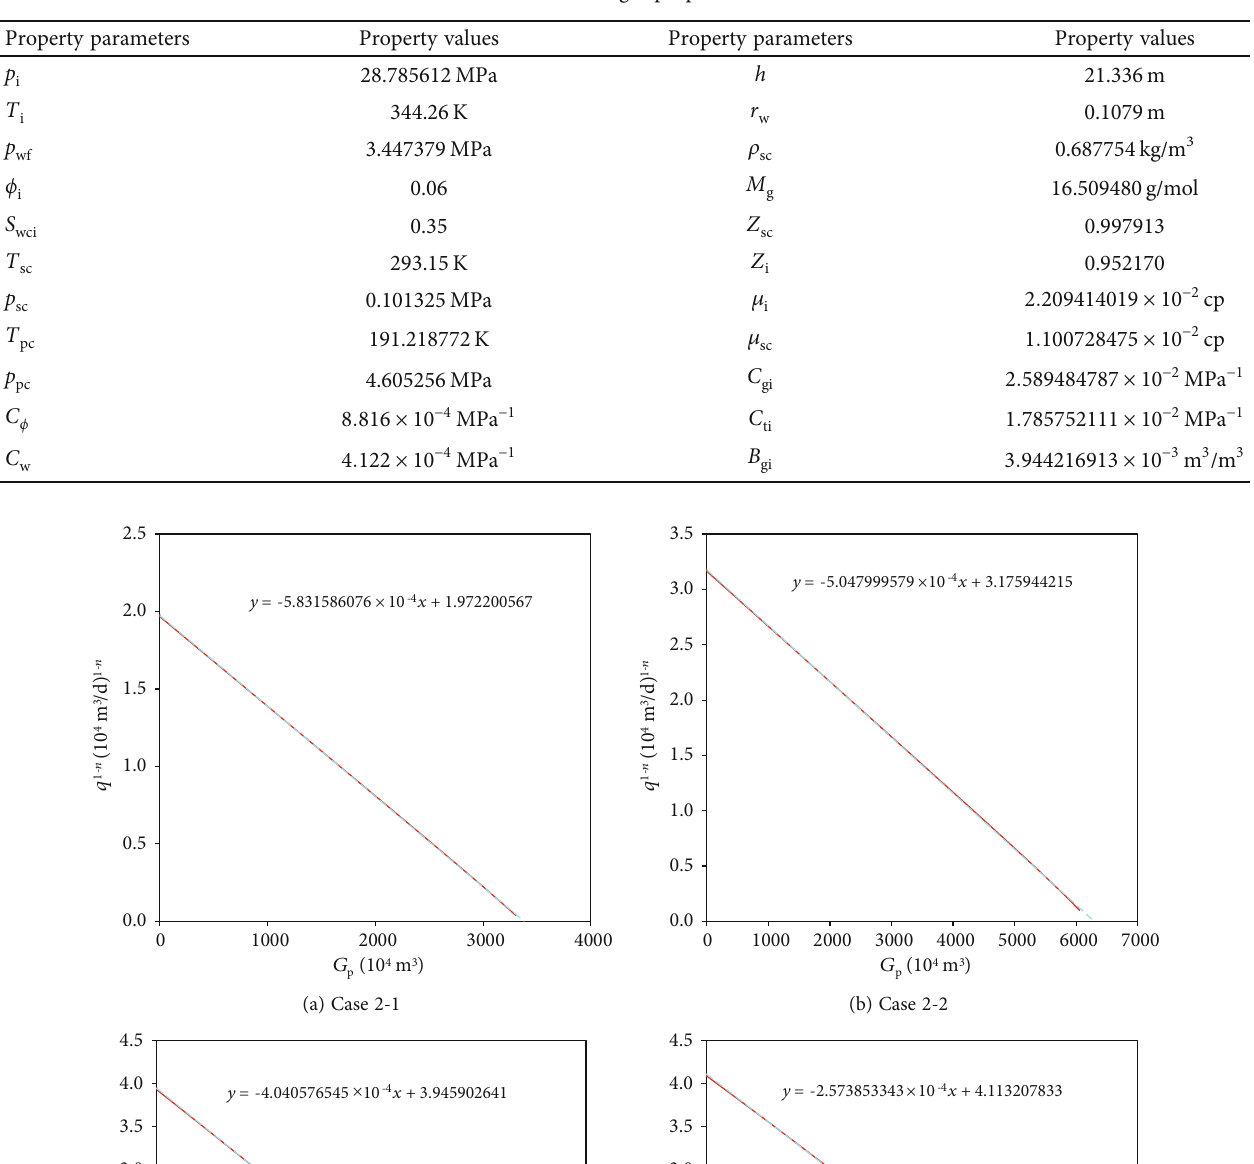
Table 7: Reservoir and gas properties for Case 3.